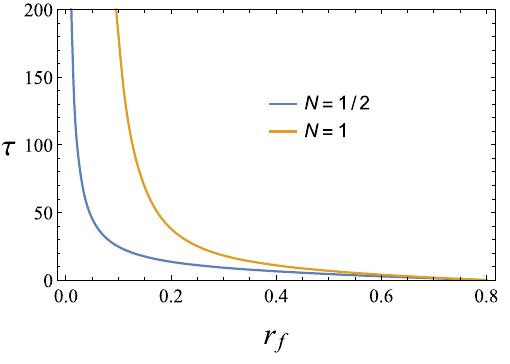
Fig. 4 τ with respect to r f for the two cases of N = 1 / 2 and N = 1, where L = 0 . 45, the initial position r i = 0 . 8, and energy E = 0 .